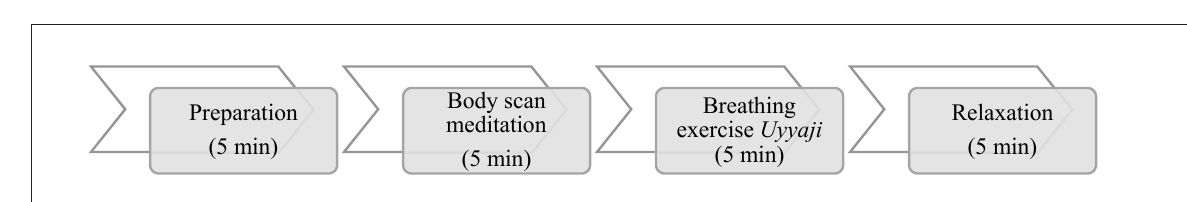
Figure 1. ECG screening procedure